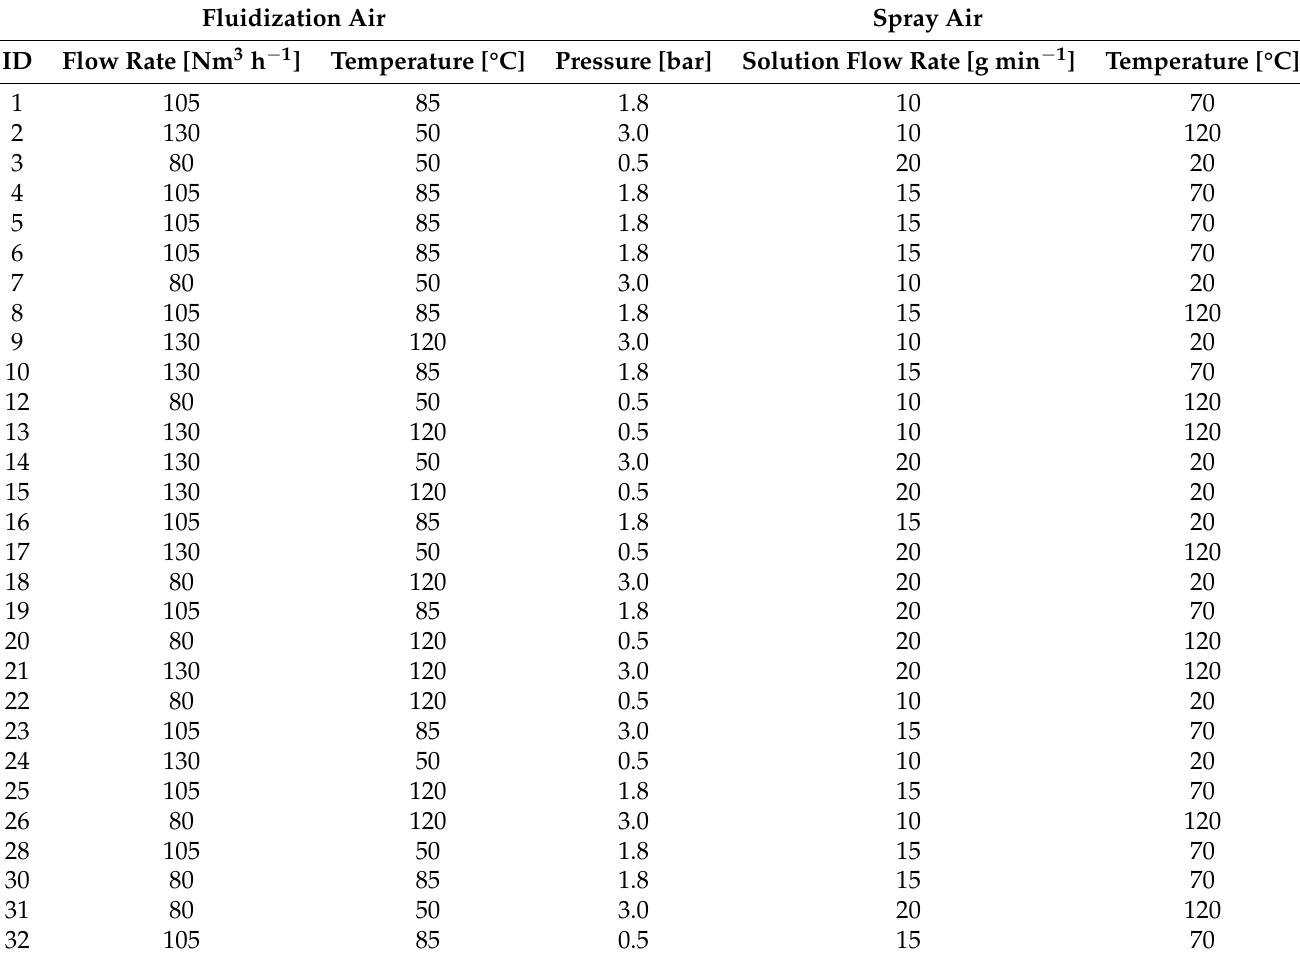
Table 2. Experimental plan used for the sodium benzoate on Cellets experiments performed in the lab-scale